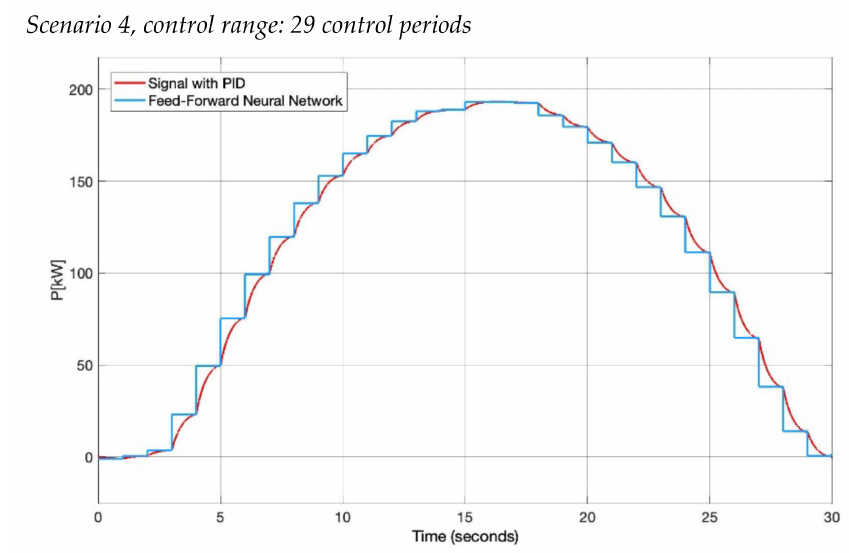
Figure 27. Control signal for BESS, p.f. = 0.95, R—week.